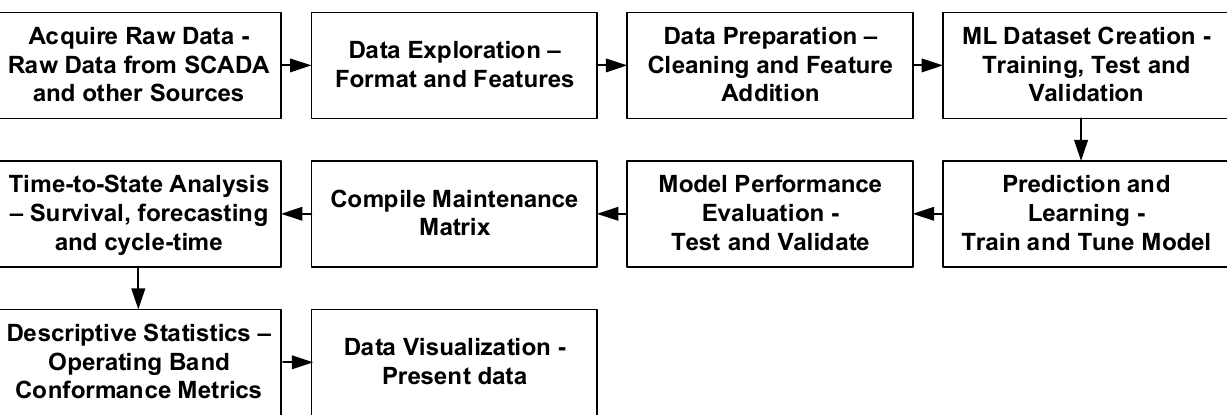
Figure 4. Data analysis framework.